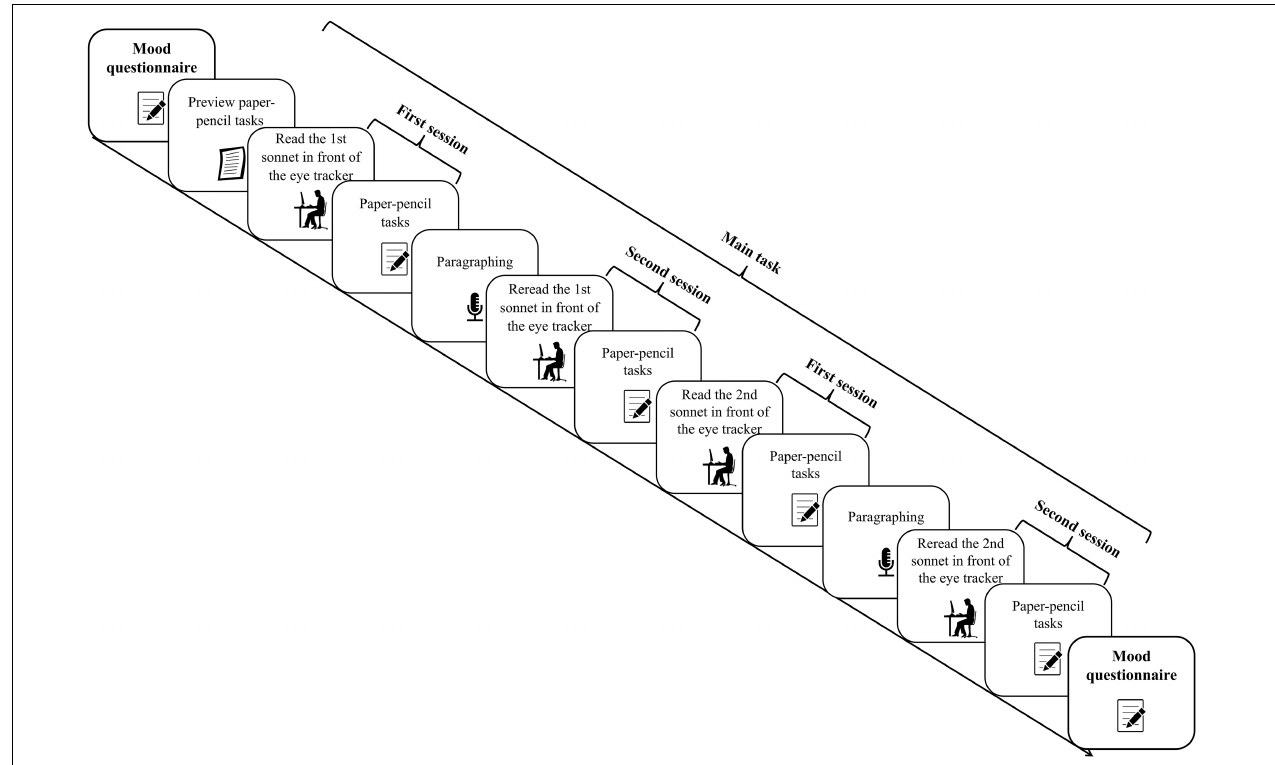
FIGURE 1 | The procedure of the experiment. “1st” and “2nd” refer to the first and second sonnet.